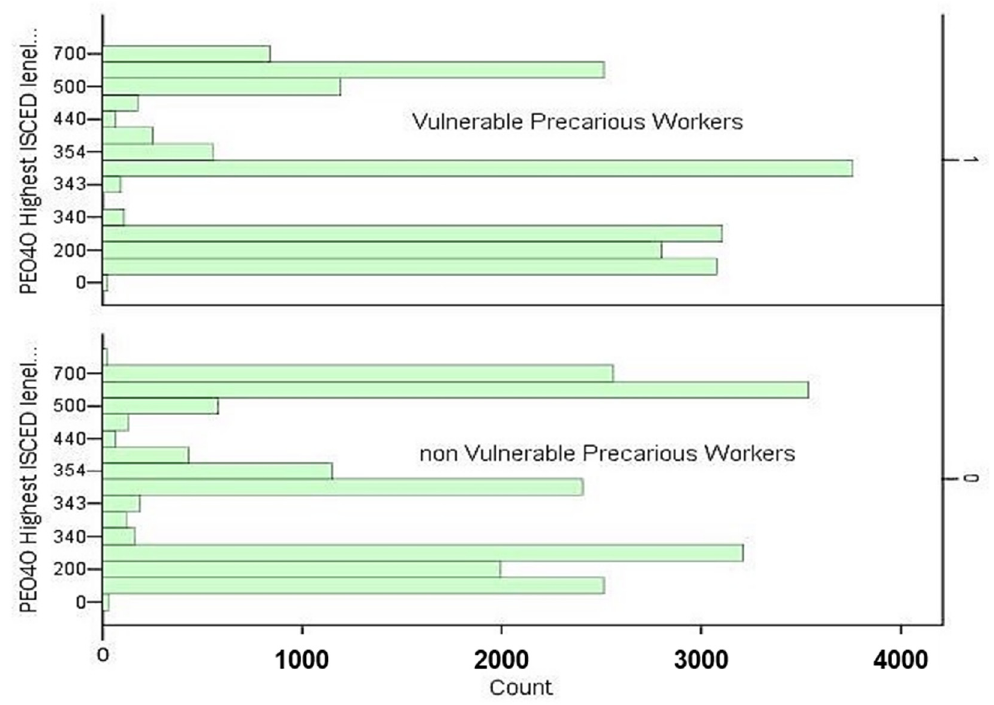
Figure 19. Distribution of precarious workers by education and economic vulnerability (2019). Data source: EU-SILC (2020).